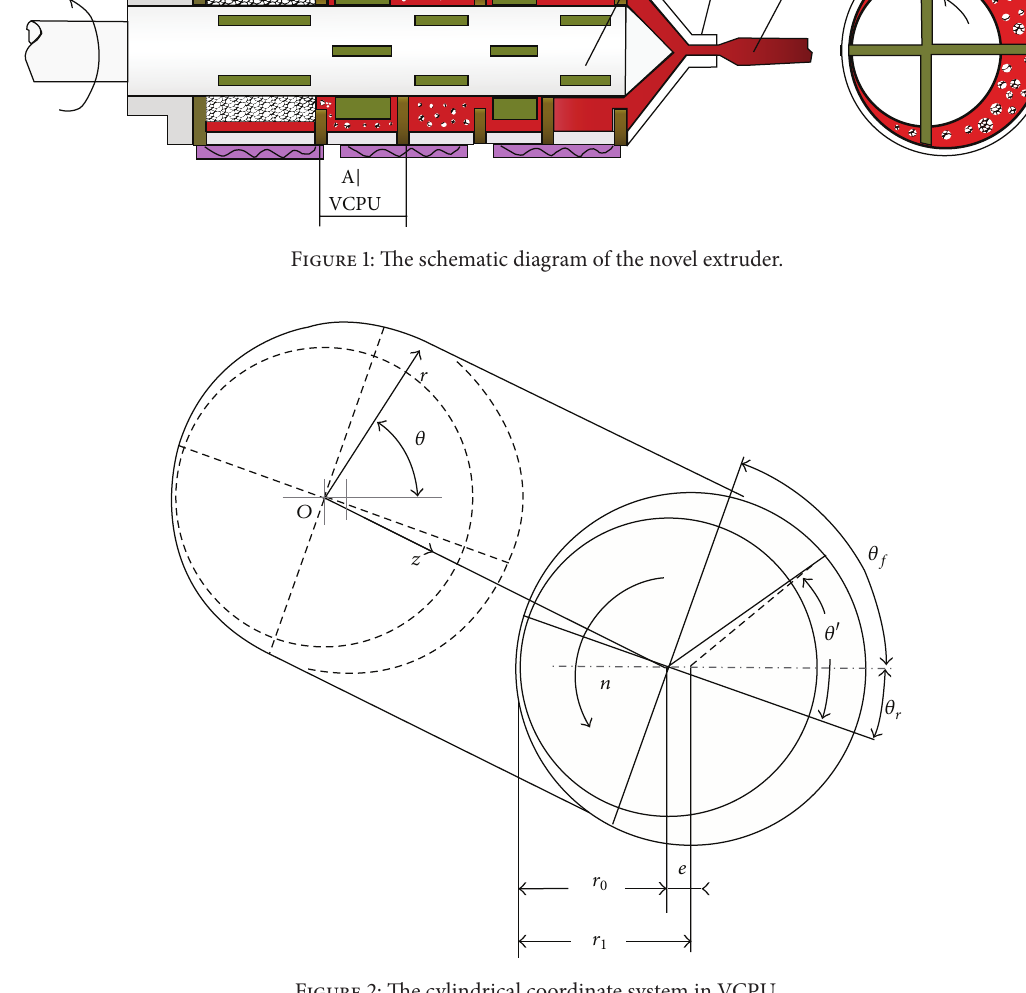
Figure 2: The cylindrical coordinate system in